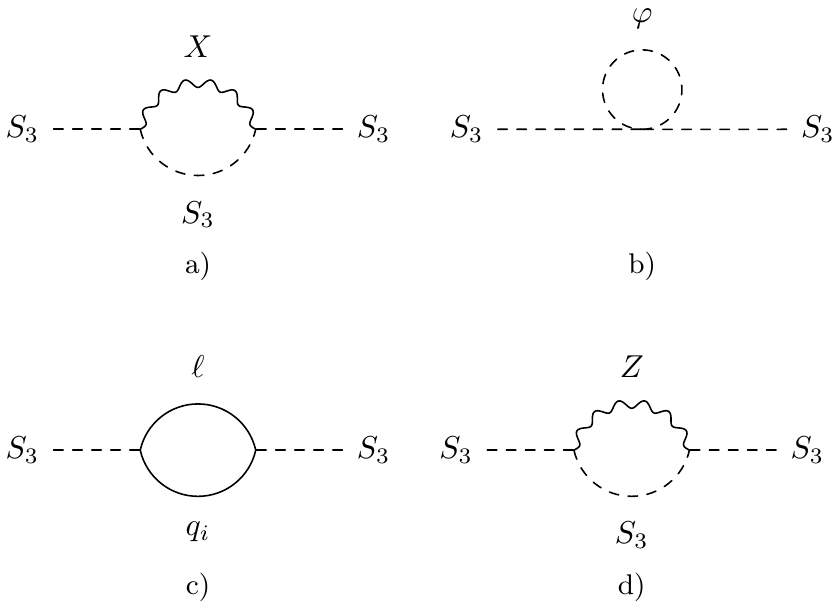
Figure 6 . Example one-loop Feynman diagrams contributing to radiative corrections to the lepto- quark mass, from a) the X gauge boson, b) the Φ scalar, c) SM fermions, and d) EW gauge bosons. constraints on the parameter space of our charged leptoquark model. These constraints do not appear in any of figures 3, 4, or 5, where we plot only the finite naturalness contours coming from the Higgs mass